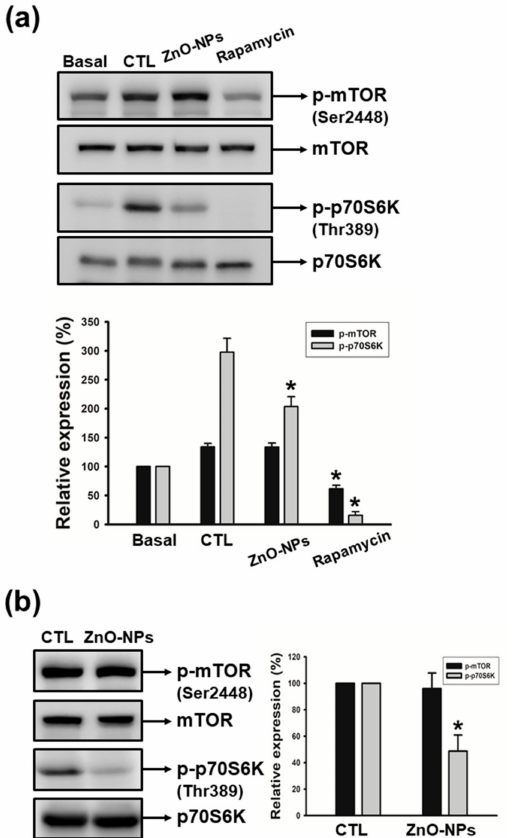
Figure 6. E ff ects of ZnO-NPs on the activation of mTOR and p70S6K in human GSCC cells. ( a ) Quiescent Ca9-22 cells were treated with or without culture medium (10% fetal bovine serum (FBS)) in the absence (CTL) or presence of ZnO-NPs (20 µ g / mL) or rapamycin (10 µ M). ( b ) Quiescent OECM-1 cells were treated with ZnO-NPs (50 µ g / mL). Then, cells were harvested and lysed for the detection of p -mTOR and p -p70S6K by Western blot analysis. Image-Pro Plus processing software quantified the relative level of phosphorylated protein. Data represent the mean ± SEM of five independent experiments. * p < 0.05 compared with the control